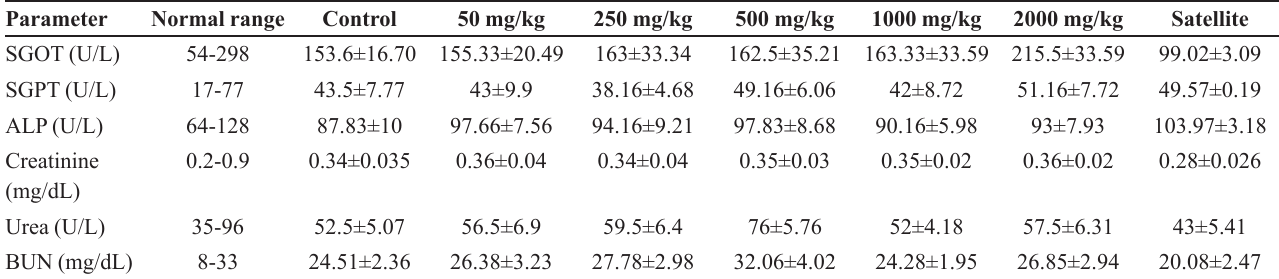
TABLE V - Biochemical estimation from blood serum of rats after 14th day’s treatment at the different dose level in the subacute toxicity study